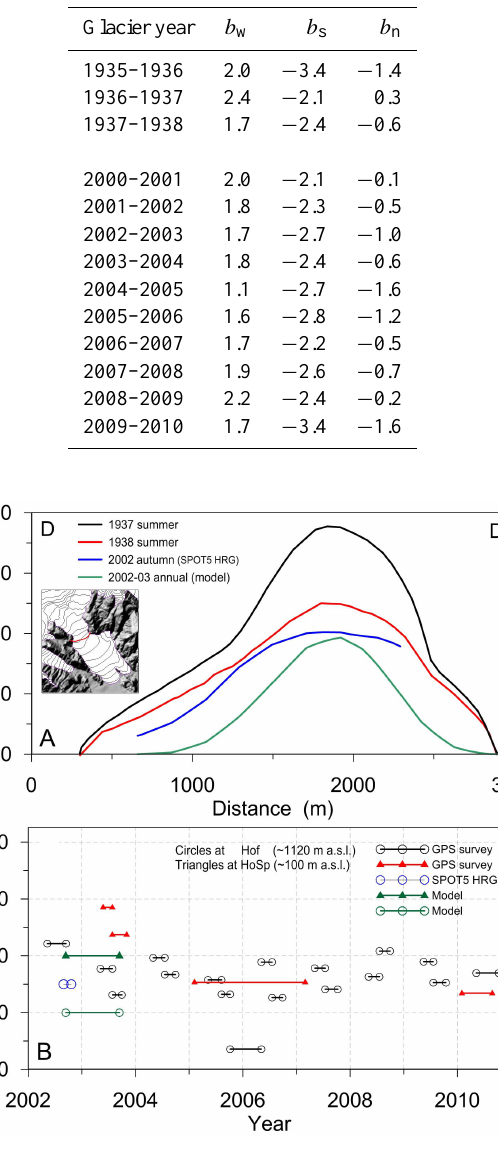
Fig. 6. (A) Surface velocity along the profile DD’ shown in Fig. 4. Velocity was measured at several stakes in summers 1937 and 1938 (Thorarinsson, 1943), extracted from the SPOT5 HRG satellite im- ages (Fig. 7) and the annual velocity computed by the ice flow model at glaciological year 2002–2003. (B) Measured surface ve- locity at the mass balance stakes Hof ( ∼ 1120ma.s.l.) and HoSp ( ∼ 100ma.s.l.). Spring, mid-summer and autumn measurements give 2–3 observations every year since 2002. For comparison, the SPOT5 HRG velocity at Hof and the annual modelled velocity at sites Hof and HoSp 2002–2003 are shown.